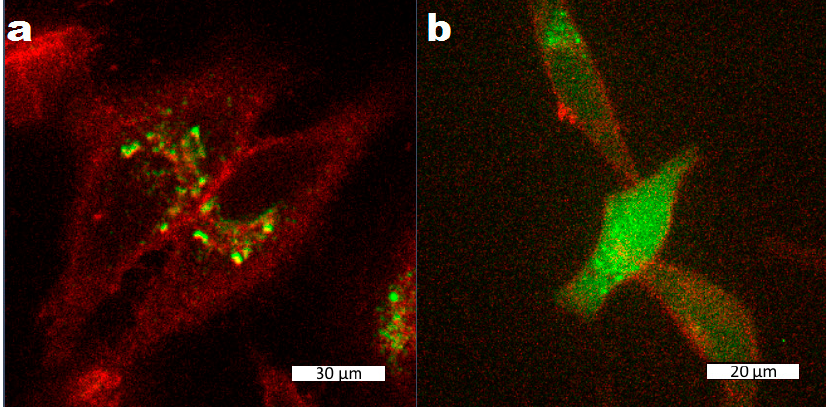
Figure 3. Liposome-coated MIL-88A nanoparticles loaded with calcein after two ( a ) and three ( b ) days of incubation with HeLa cells. The cells have been marked with CellMask Orange. The scale bars correspond to 30 µm ( a ) and 20 µm ( b ).